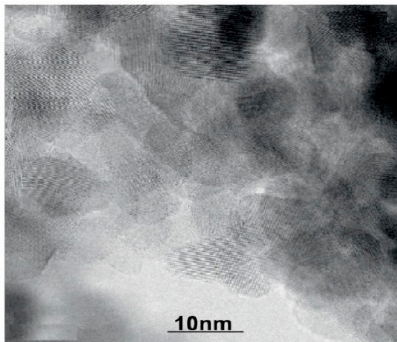
Figure 2. SEM images of nanoparticles after dispersion (20% alumina and 80% titanium).